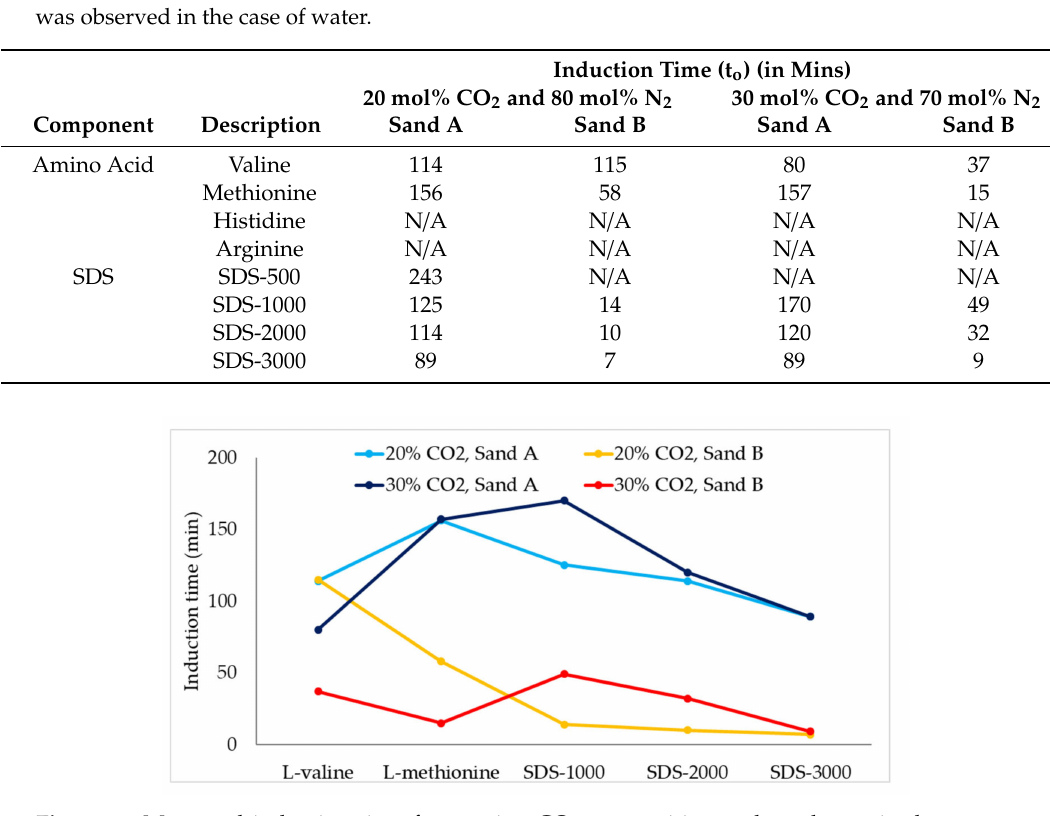
Figure 8. Measured induction time for varying CO 2 composition and sand type in the presence of SDS and amino acids during the isothermal experiments. The numbers beside SDS refer to the ppm